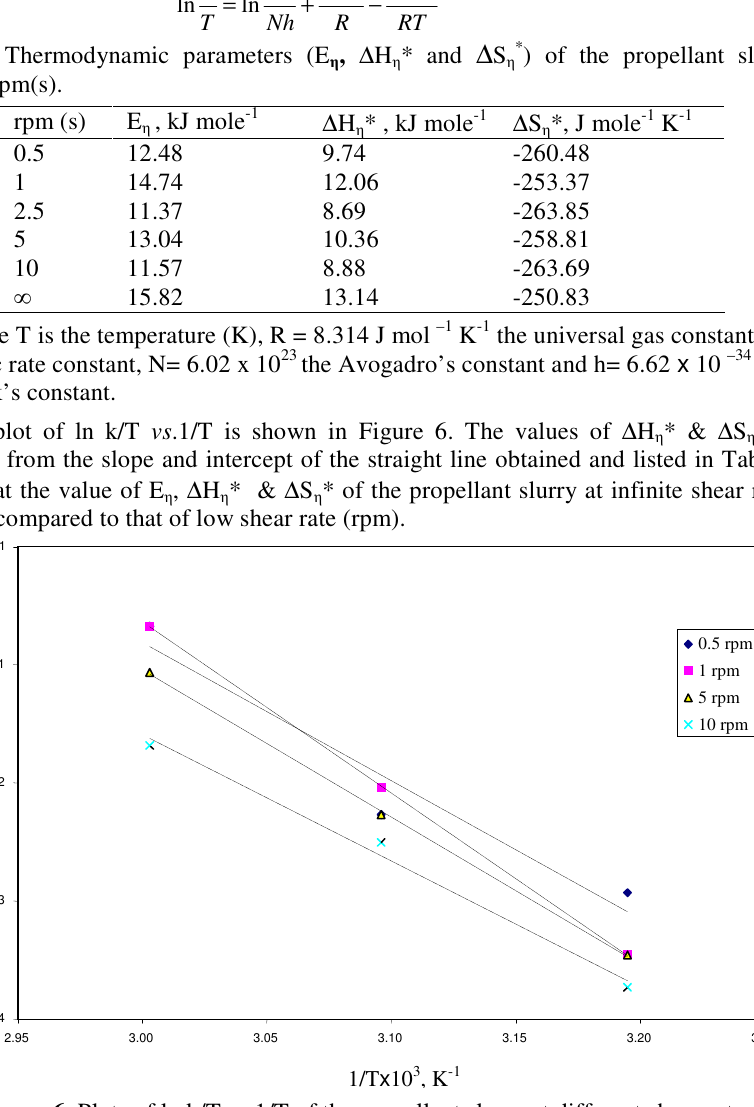
* ) of the propellant slurry at , ∆ H * and ∆ S η η η